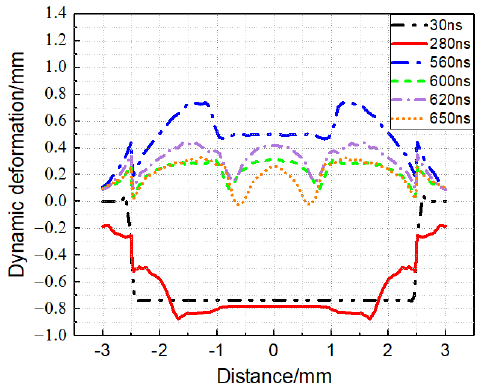
Figure 11. Radial deformation distributions of impact surface at different times.